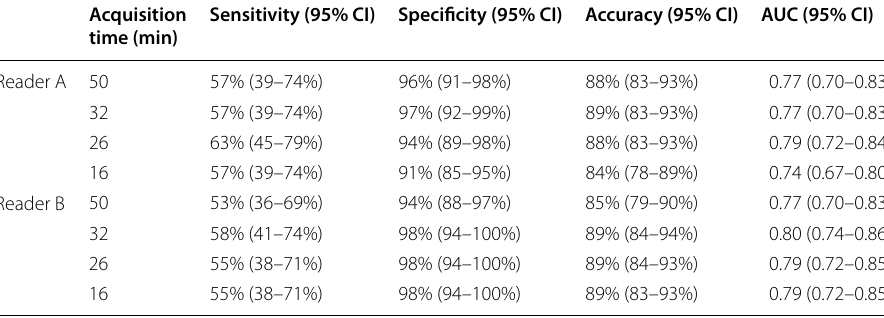
Table 4 Region-level analysis with decreasing acquisition